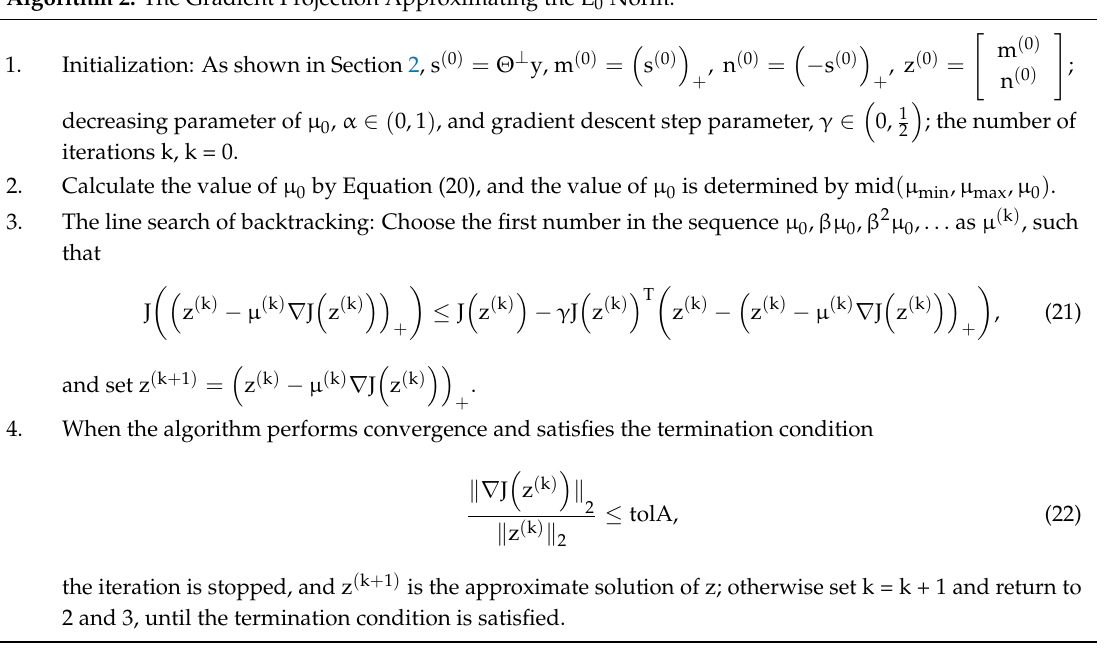
Algorithm 2. The Gradient Projection Approximating the L 0